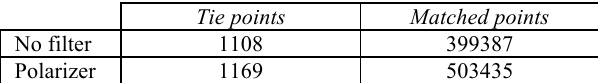
Table 5. Ceramic object #2 (Etruscan olpe). Matching results for different image